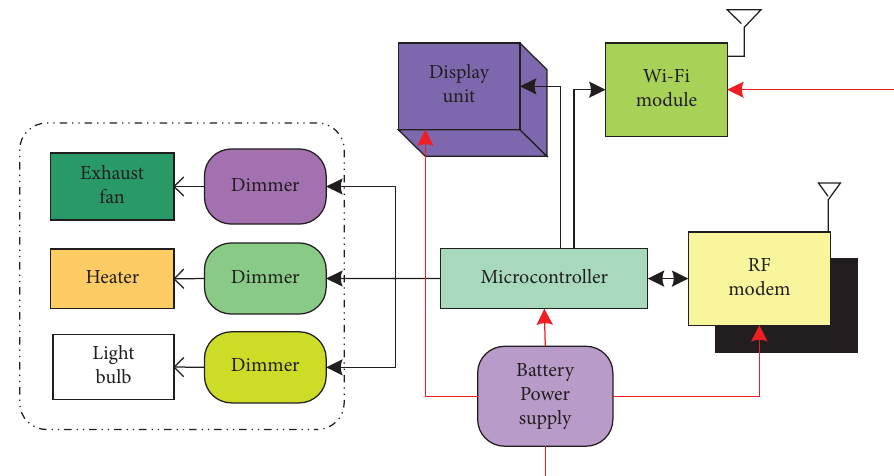
Figure 3: Block diagram of a receiver